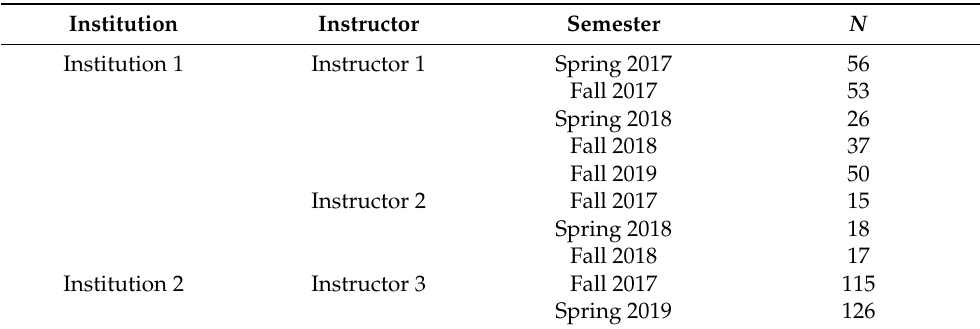
Table 1. Number of students consenting to participate in each course by semester, instructor and